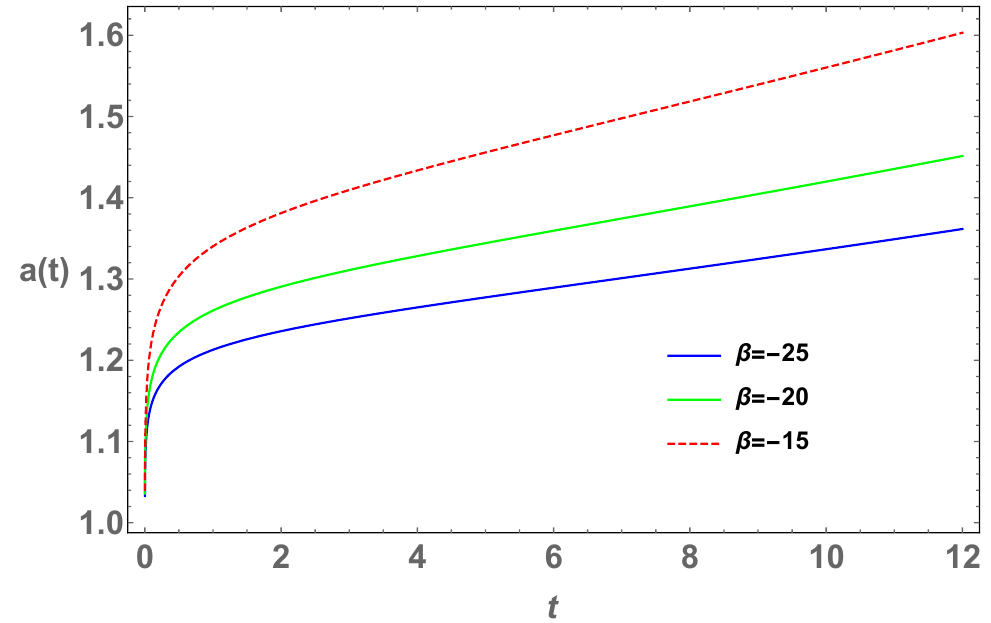
Figure 5. Evolution of the scale factor a ( t ) with respect to cosmic time t for different values of β with γ = 1.65, k =